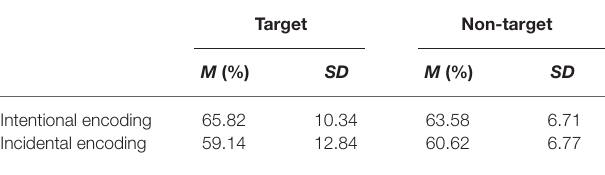
TABLE 1 | Performance in the different